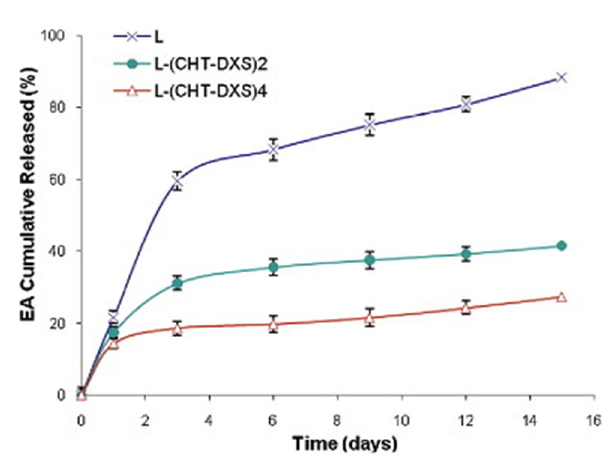
Figure 8. Release profiles for ellagic acid from bare liposomes (L) and biopolymer-coated lipo- somes with two and four bilayers (CHT: chitosan and DXS: dextran sulfate). Data adapted from reference [254] , Copyright (2010), with permission from Elsevier.